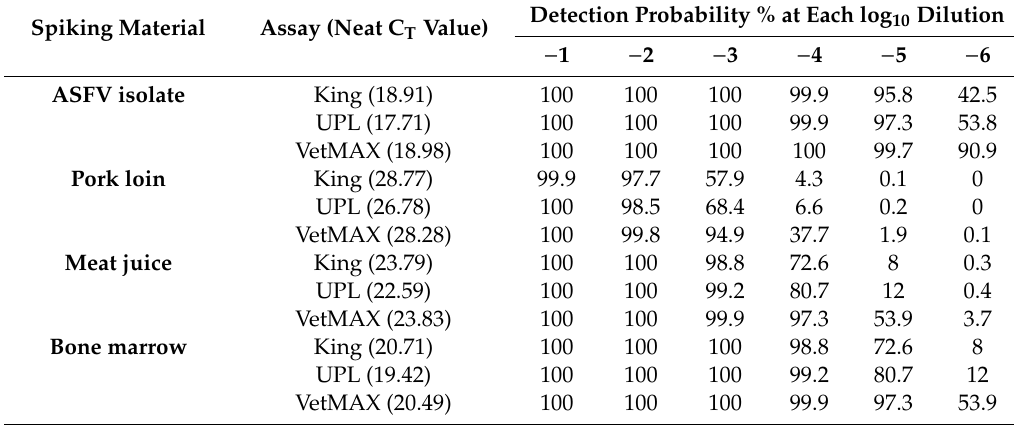
Table 3. Estimated probability (%) of a positive test result for each assay, material and dilution. Spiking Material